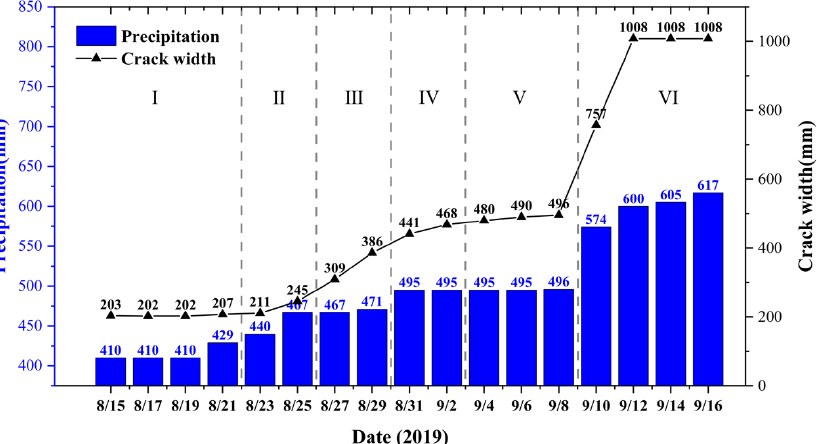
Figure 5. Relationship between rainfall and crack width.